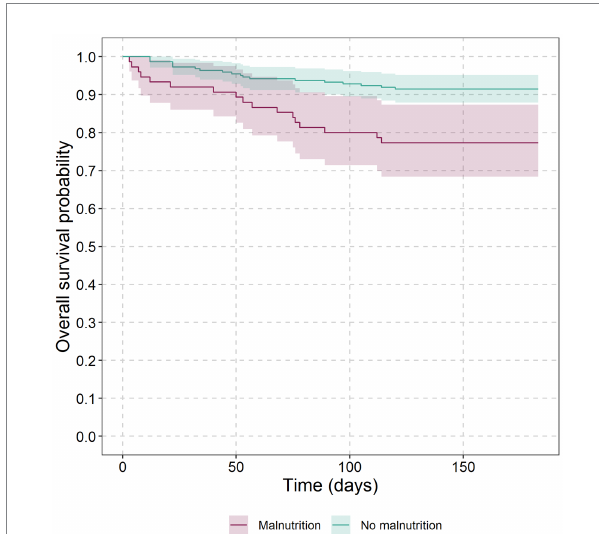
FIGURE 1 Kaplan-Meier curves for older ED patients with and without malnutrition from the beginning of the initial hospital stay after ED until the follow up at six months without adjustment. Number of patients at risk and patients who died at selected time points for malnutrition: 0 days (75 vs. 0), 50 days (68 vs. 8), 100 days (60 vs. 15) and 150 days (58 vs. 17); no malnutrition: 0 days (223 vs. 0), 50 days (213 vs. 10), 100 days (207 vs. 16) and 150 days (204 vs.